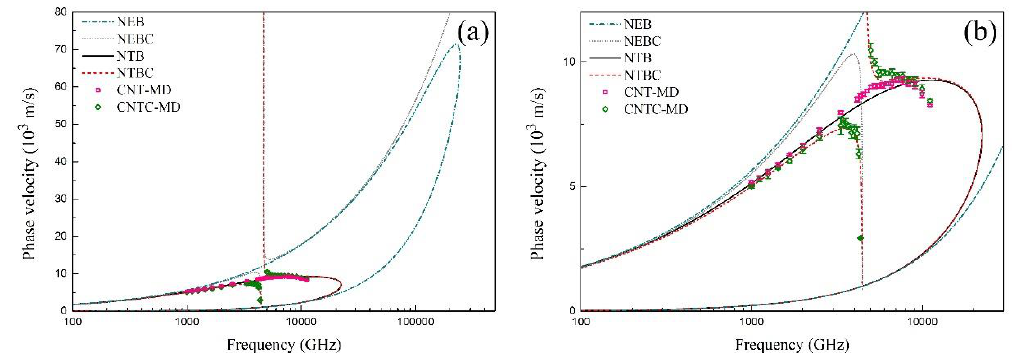
Figure 3. The dispersion relation of the SWCNT and the CCSC obtained by different beam models and MD simulations. ( a ) The dependence of the phase velocity of the sinusoidal flexural wave on the wave frequency; ( b ) the zoom of ( a ).